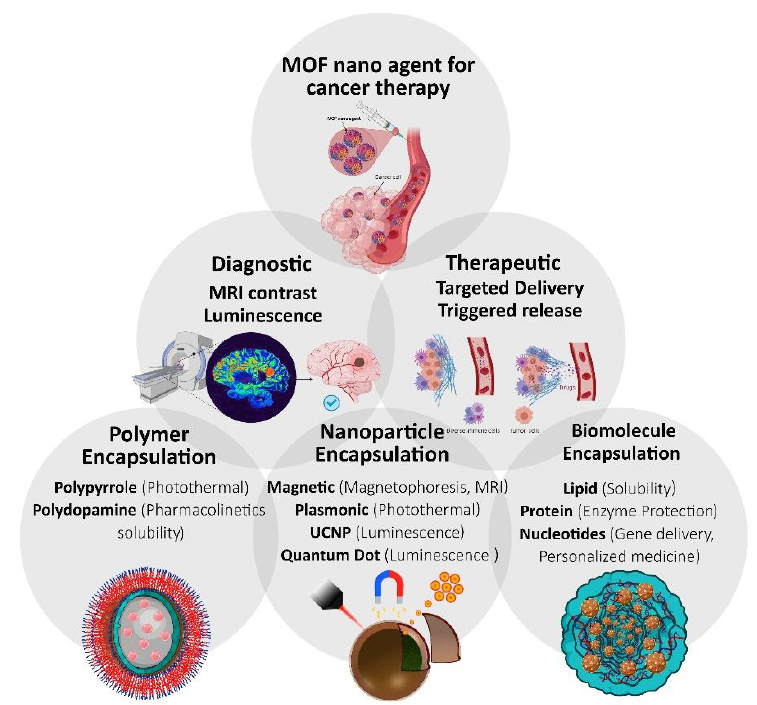
Figure 1. Main scope of this perspective regarding the use of MOFs-based nanomaterials for advanced cancer therapy.